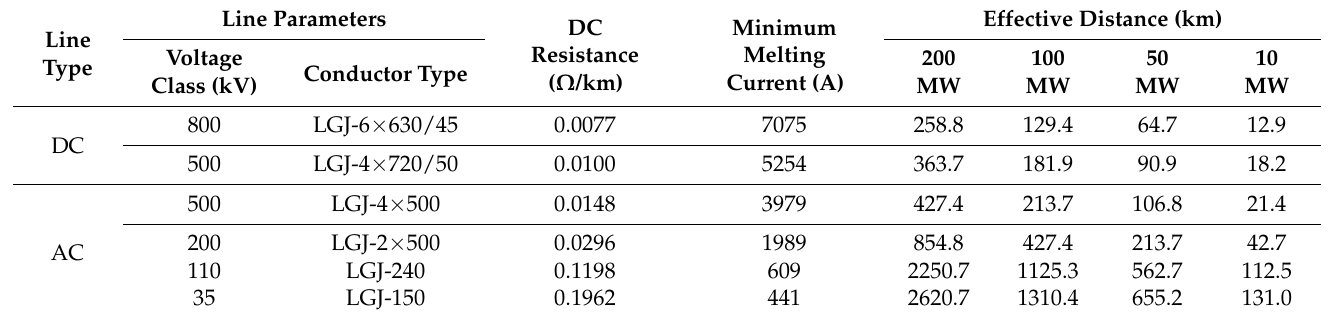
Table 1. Length of various types of de-icing transmission lines determined by the capacity of DC devices